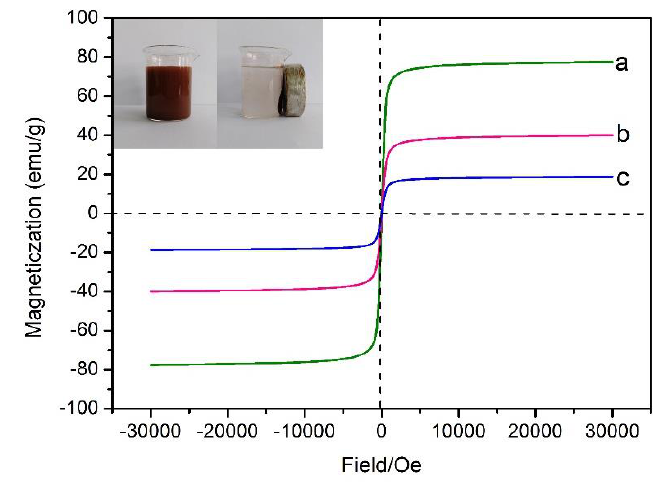
Figure 8. Room temperature magnetization curves for Fe 3 O 4 microsphere ( a ), Fe 3 O 4 @MIL-100(Fe) support ( b ) and the immobilized lipase ( c ).